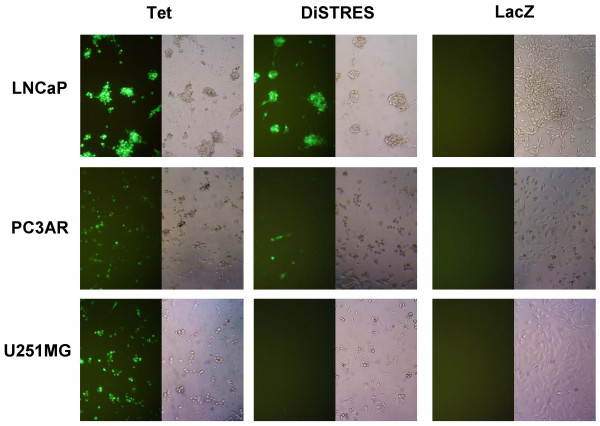
Ad/FasL-GFPDiSTRES demonstrates prostate-specific cytotoxicity as indicated by rounded morphology of prostate cancer cells. LNCaP, PC3AR, and U251MG cells were seeded at and infected as described in Fig. 5. LNCaP, PC3AR, and U251MG were infected at MOI 10, 5, and 5, respectively. Two days post-infection, cells were visualized using Axiovert-25 fluorescent microscope with FITC filter set and photos taken with Pixera digital camera at 100× magnification. Photos on the left were taken under UV light. Photos on the right were taken under bright field setting. MOI values are based on pfu/ml.